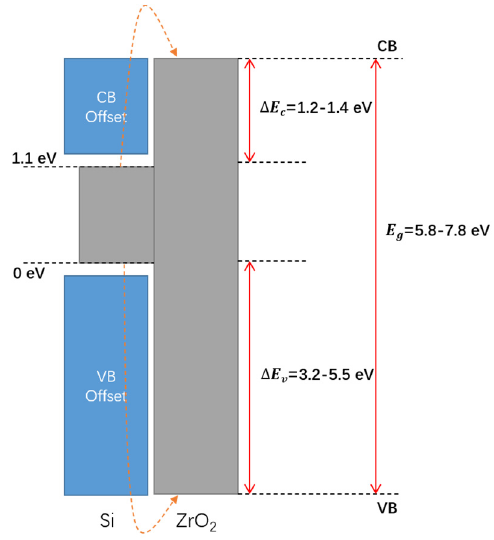
Figure 1. Schematic of bandgap and band offsets of ZrO 2 and carrier injection mechanism in its band states. CB conduction band, VB valence band.